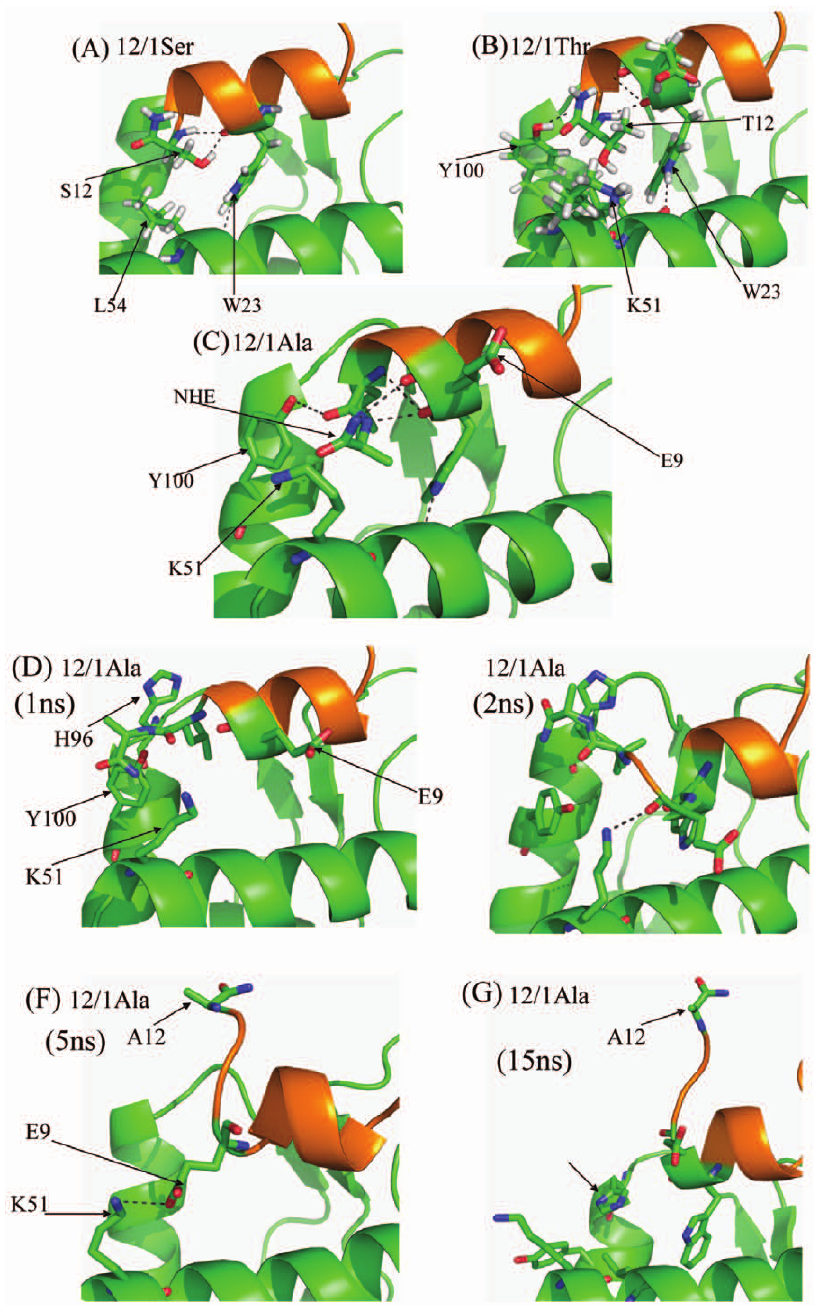
Figure 7. Representative snapshots from the trajectories of 12/1 mutant peptides complexed with MDM2. Snapshots from the trajectories of 12/1 mutant peptides complexed with MDM2. The (A) N12S, (B) N12T and (C) N12A MD simulations were started with a modeled helix at the C-terminus. Figures 7D) to 7G) show different orientations of the C-terminus of the N12A 12/1 mutant at different time points of the MD simulation trajectory (also see Movies S1).